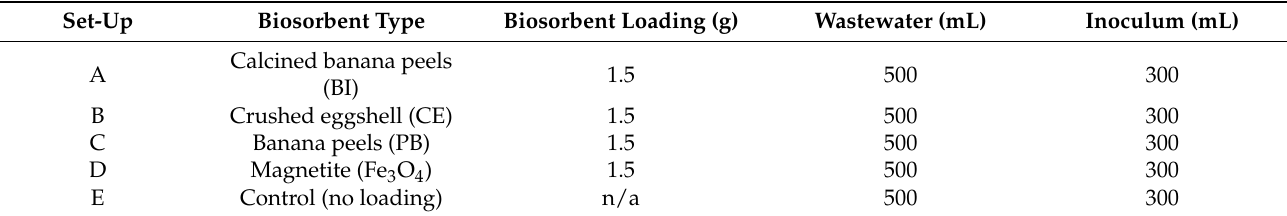
Figure 1. A biochemical methane potential (BMP) test set-up. Table 3. The biosorbent loading for the BMP